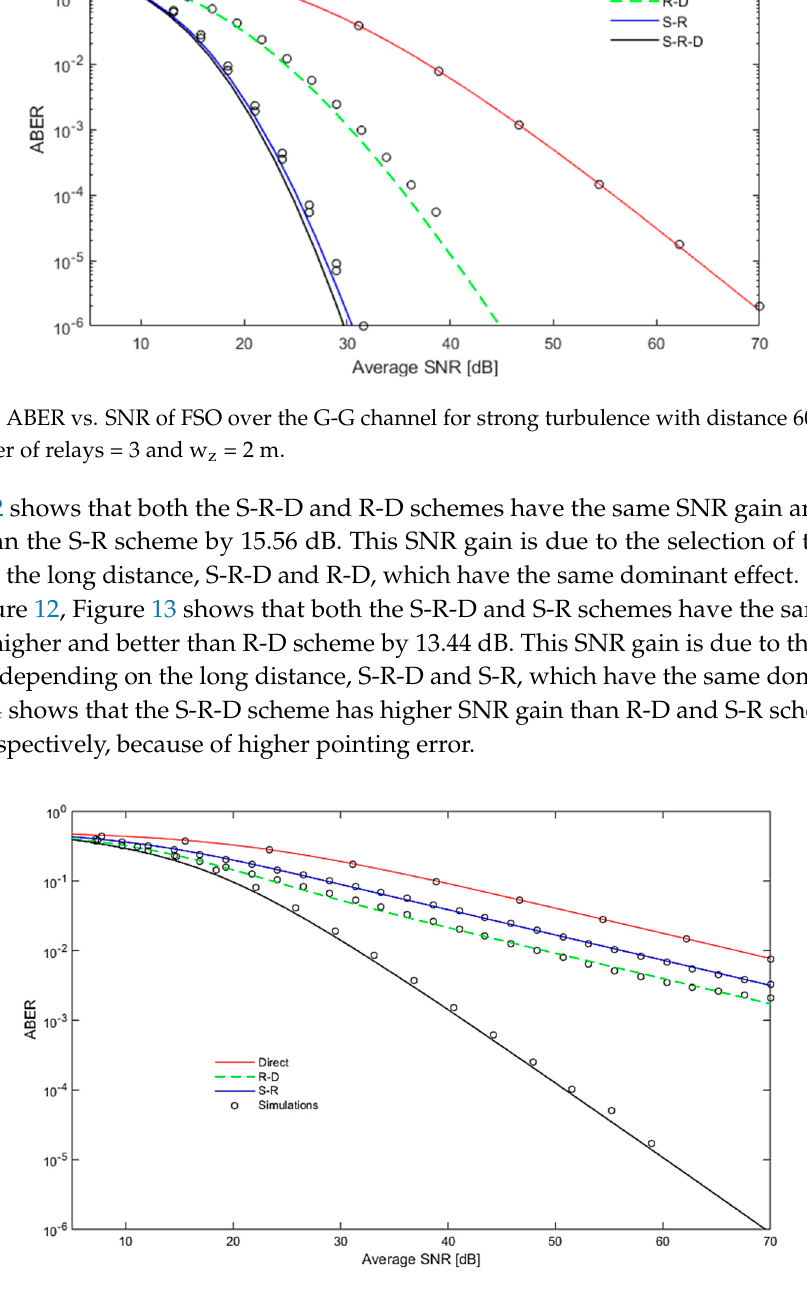
Figure 14. ABER vs. SNR of FSO over G-G channel for strong turbulence with distance 400–600 m, the number of relays = 3, and w z = 0.5 m.